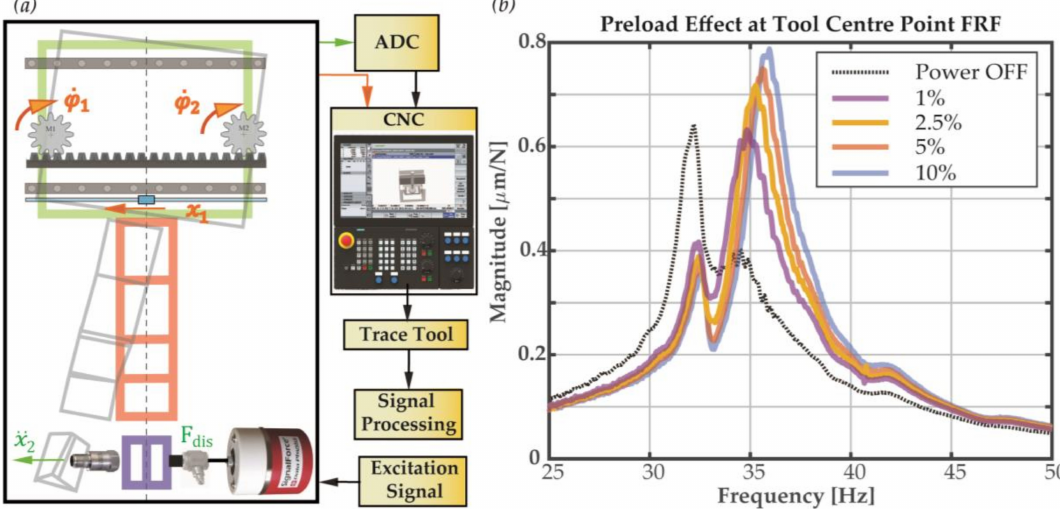
Figure 6. ( a ) Overall experimental implementation concept sketch, ( b ) Tool centre point frequency response function (FRF) for di ff erent preload